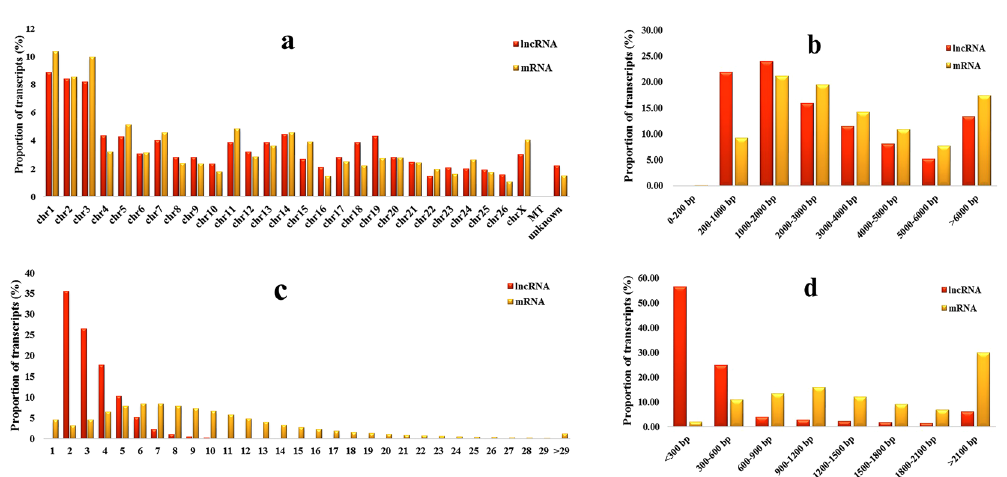
Figure 4. Identification of lncRNAs and mRNAs in sheep testes. ( a ) Distribution of lncRNAs and mRNAs in chromosomes. ( b ) Length of lncRNAs and mRNAs. ( c ) Exonic content of lncRNAs and mRNAs. ( d ) Length of the open reading frame of lncRNAs and